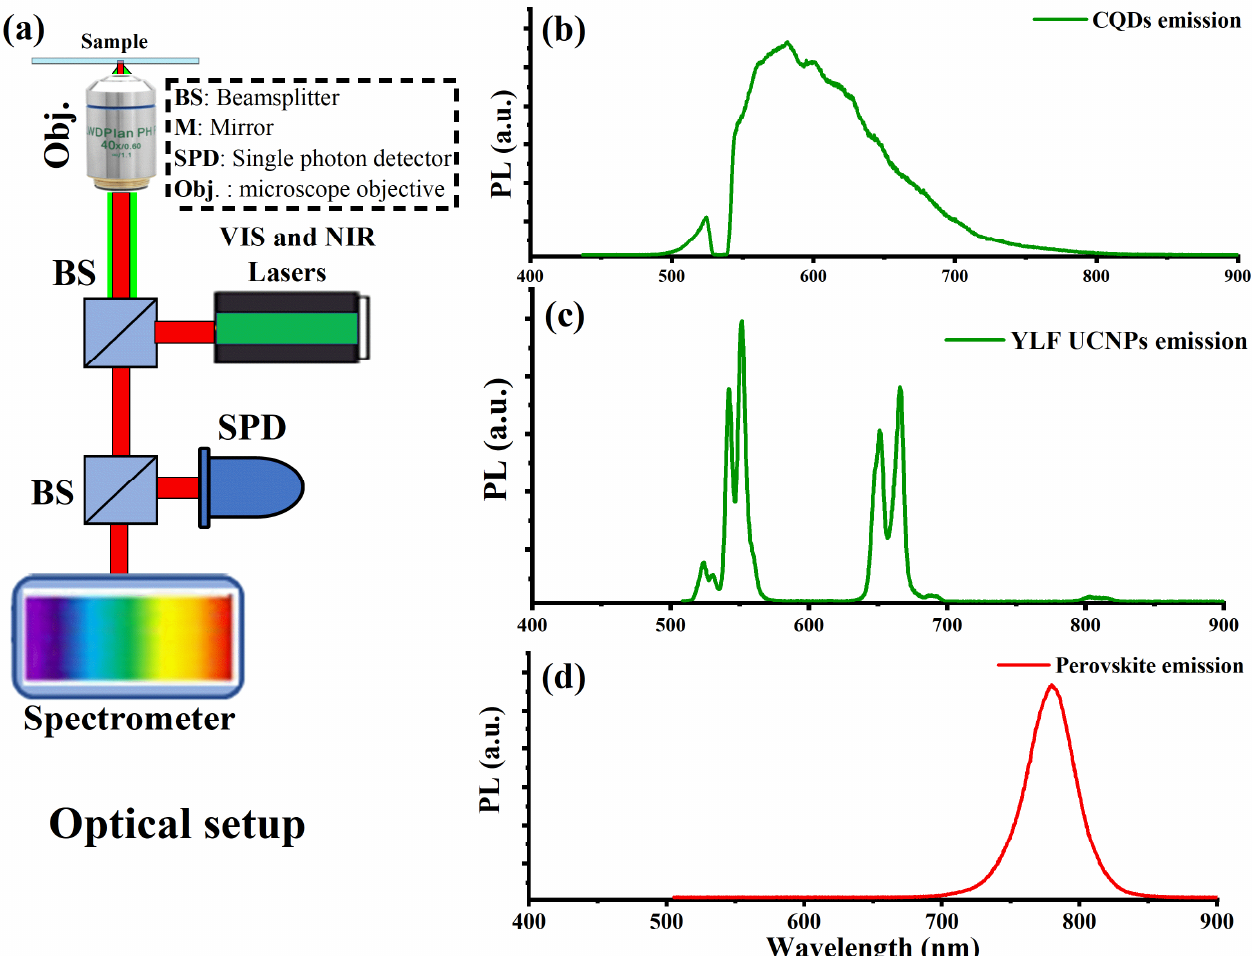
Figure 3. ( a ) Schematic of a home-made confocal microscope developed and fitted with near-infrared and visible lasers for photoluminescence (PL) measurements. The CQD spectrum, measured directly from the CQD nanoparticles, is shown in the optical spectrum in ( b ). ( c ) Visible emission of UCNPs, which consists of two emission bands in the red and green regions that correspond to the Er +3 optical transition under 980 nm laser stimulation. Additionally, ( d ) displays the PL spectra of the perovskite layer, centered at 780 nm under green excitation.